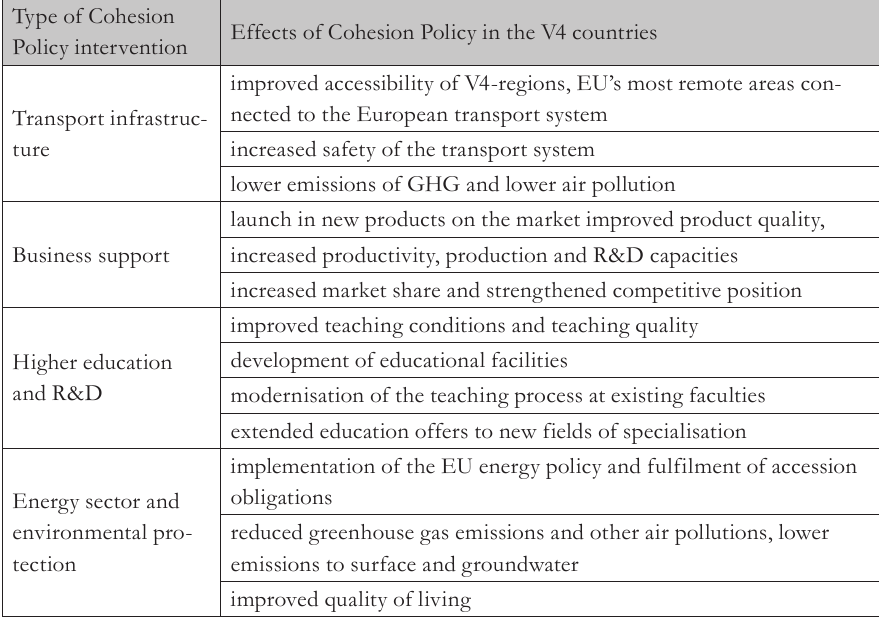
Tab. 1 – The Effects of Cohesion Policy in the V4 countries. Source: How do EU-15 Member States Benefit from the Cohesion Policy in the